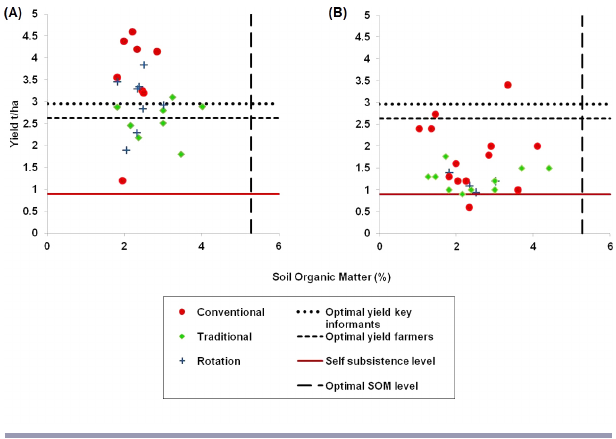
Fig. 2. Trade-offs between maize yield and soil fertility in the Pátzcuaro Lake watershed, Mexico. (A) Average year. (B) Dry